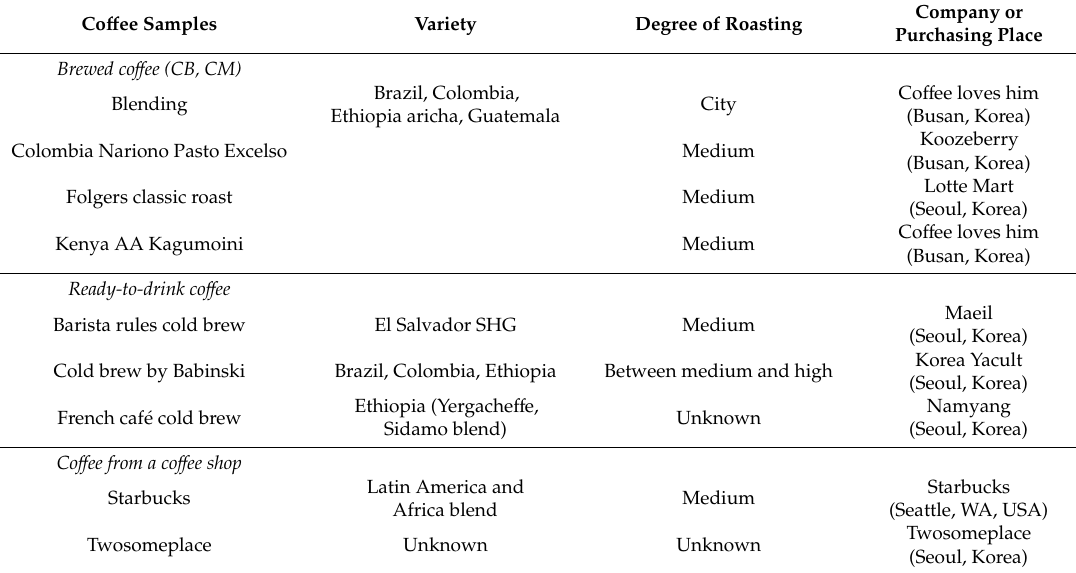
Table 1. Co ff ee-sample